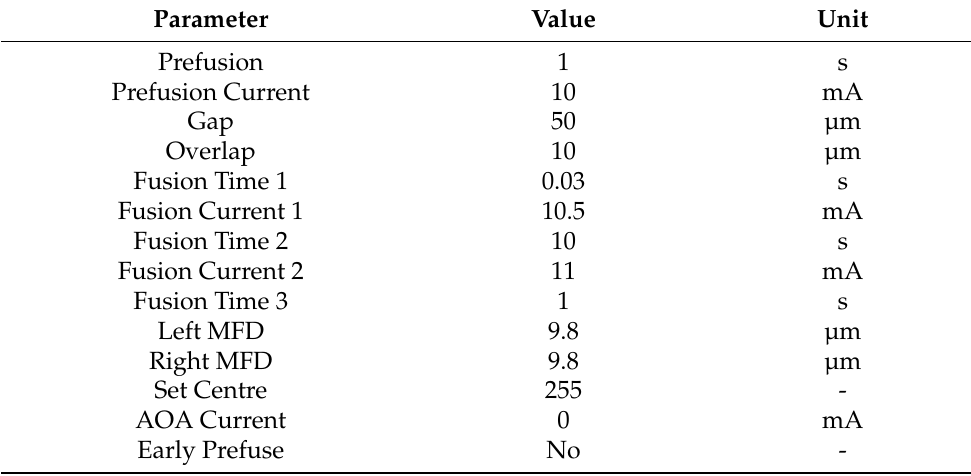
Table 1. Fusion Splicer